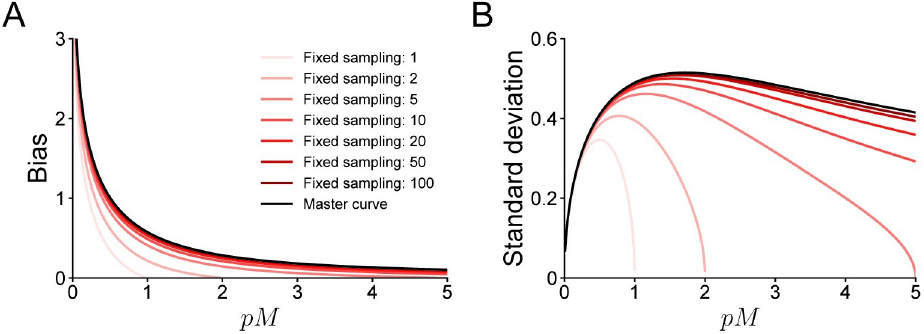
Fig 2. Asymptotic properties of fixed sampling. A . Bias of fixed sampling estimators of the log-likelihood, plotted as a function of pM , where p is the likelihood on a given trial, and M the number of samples. As M ! 1 , the bias converges to a master curve (Eq S3 in S1 Appendix). B . Same, but for standard deviation of the estimate.